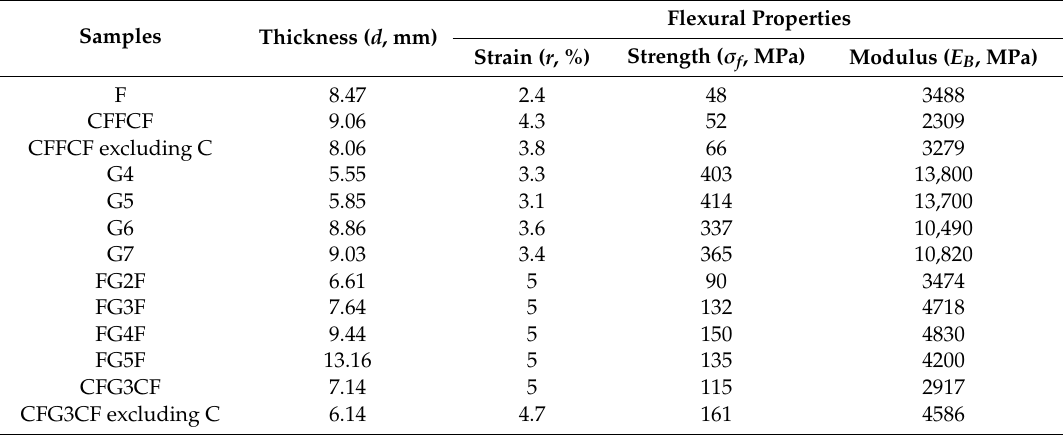
Table 4. Short-term properties of CIPP